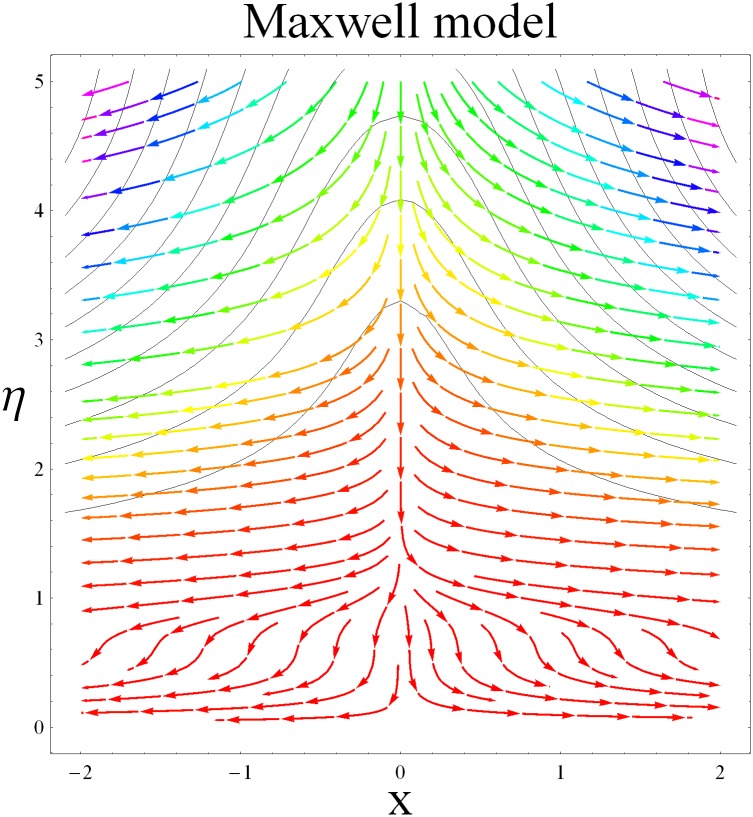
Stream lines for Maxwell model.